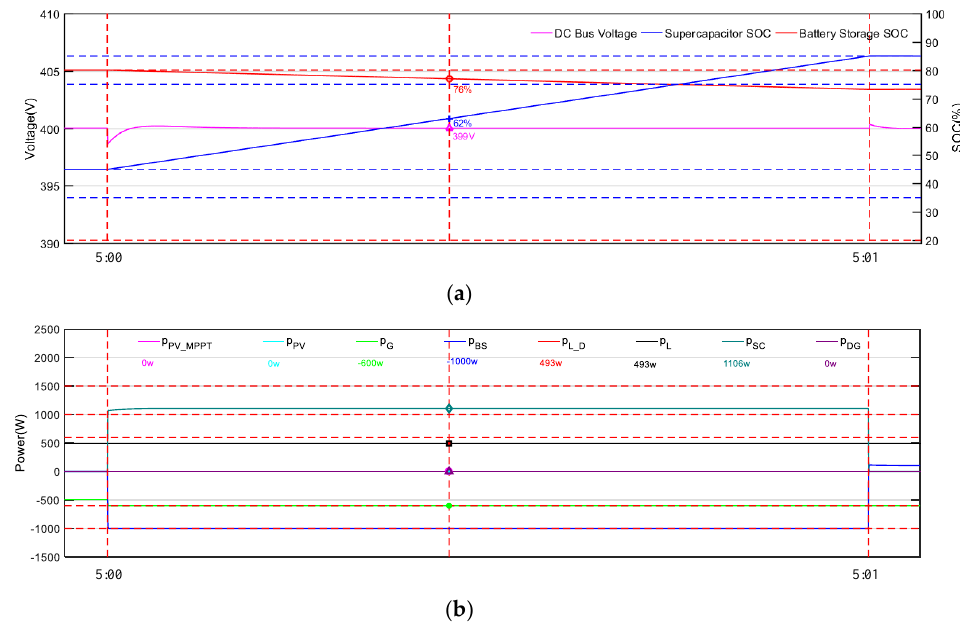
Figure 9. Curves of common DC bus voltage and SOC of storage ( a ) and curves of power ( b ) while the supercapacitor (SC) is